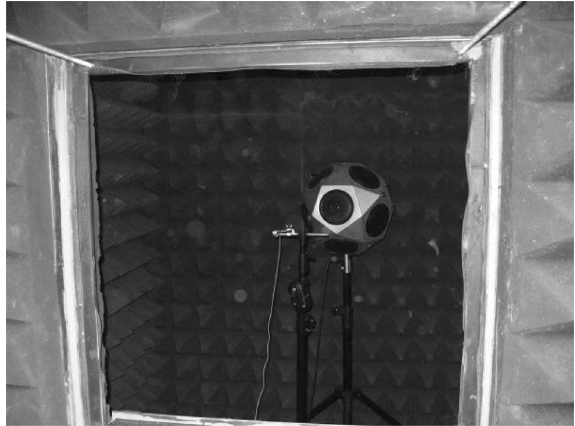
Fig. 1. Noise suppression chamber and a “window” wherein the specimen is mounted